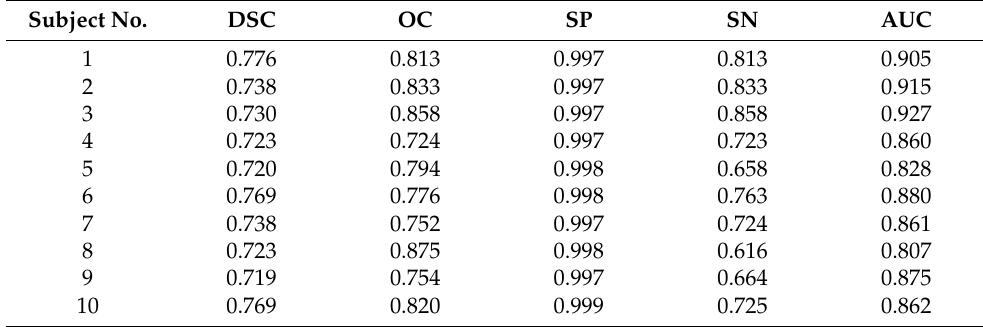
Table A4. Evaluation results for cerebellar fissures (model M1) on DLBS dataset.